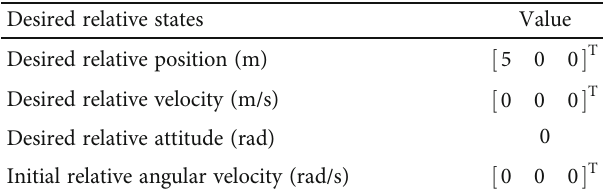
Table 3: Desired states of the chaser relative to the target [1,